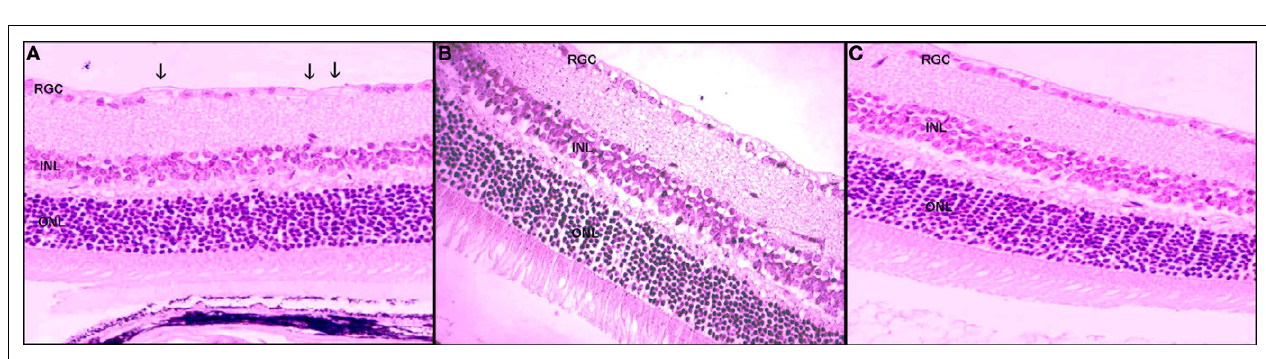
mainly in the RGC layer. (B) HBO-treated rAION. Note the minimal apoptosis compared to [ (A) × 40]. (C) Uninjured eye; no apoptosis.